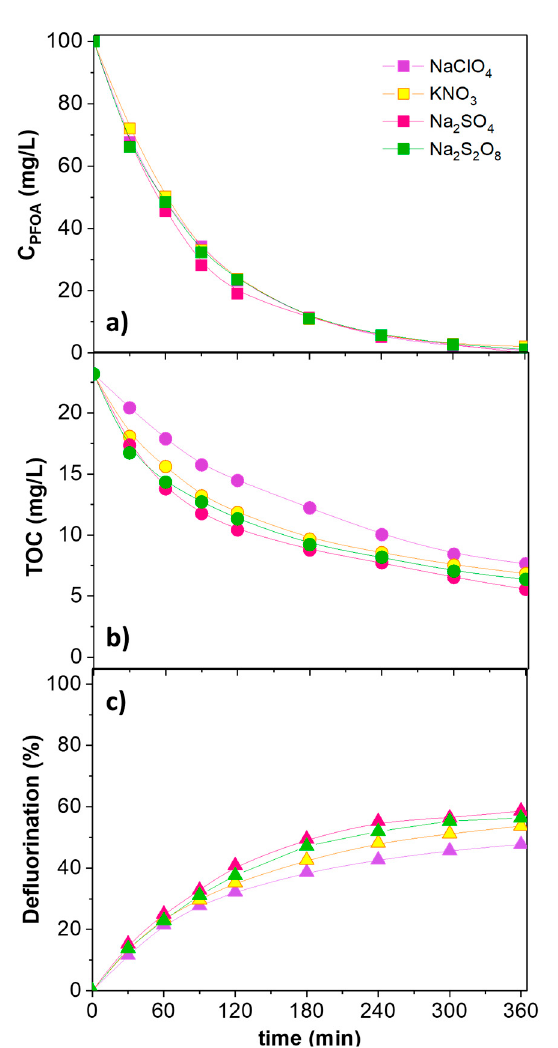
Figure 5. Influence of the electrolyte in PFOA ( a ) degradation, ( b ) mineralization, and ( c ) defluorination in electrooxidation using BDD/Pt electrodes. Operating conditions: [PFOA] 0 : 100 mg/L, j: 7.9 mA/cm 2 , electrolyte: 3.5 mM, T: 25 °C, pH 0 : 4.